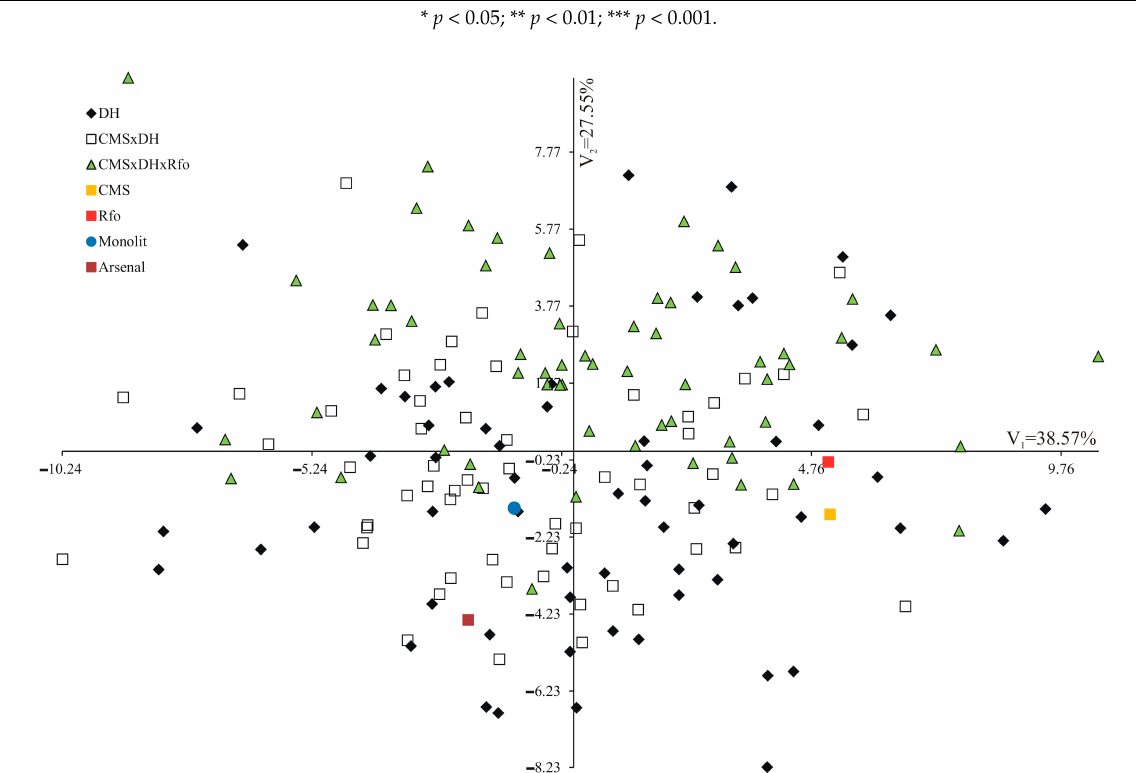
Figure 1. Distribution of 182 genotypes of winter oilseed rape ( Brassica napus L.) in the space of the first two canonical variates in